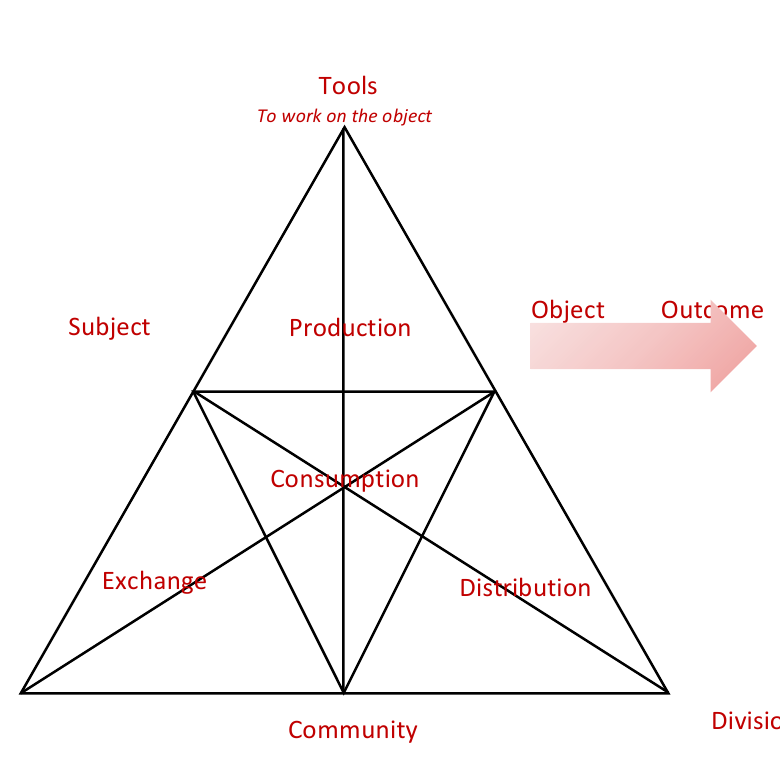
Tools To work on the object